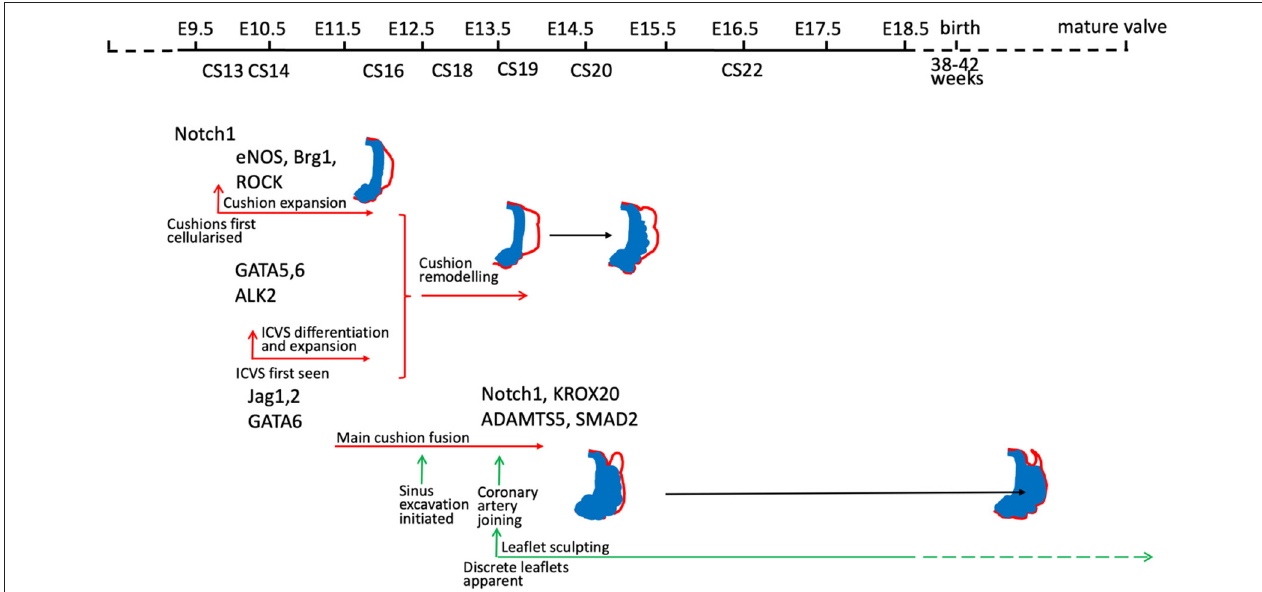
FIGURE 4 | Timeline illustrating the timing of gene activity (based on developmental process disrupted) in mouse models of BAV. Mouse models included are those for which mechanistic studies have been carried out to understand why BAV develops. Notch 1 ( 31, 71); eNOS (69, 76, 77); Brg1 (78); ROCK (30); GATA5 (70); GATA6 ( 63); ALK2 (72); Jag1/2 (31, 71); Krox20 (49), ADAMTS5/Smad2